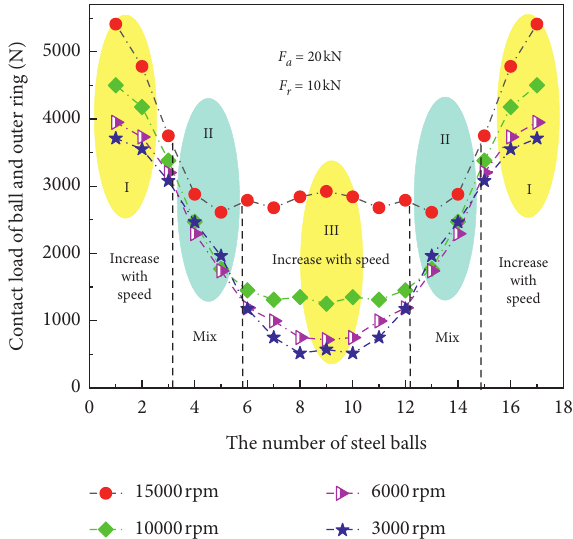
Figure 22: The variation of gyroscopic moment with different positions of rolling elements at different